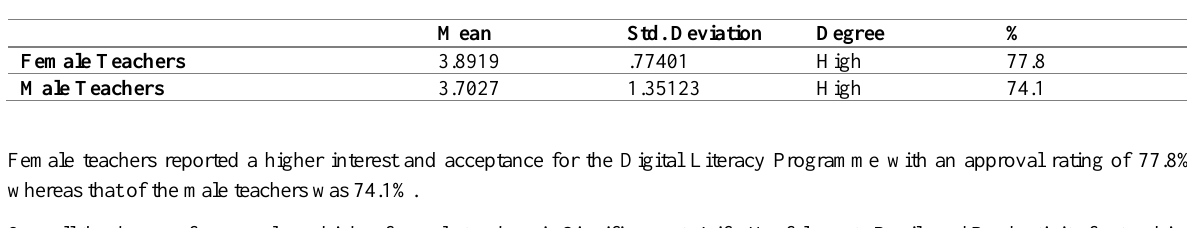
Table 5: Teachers’ Interest and